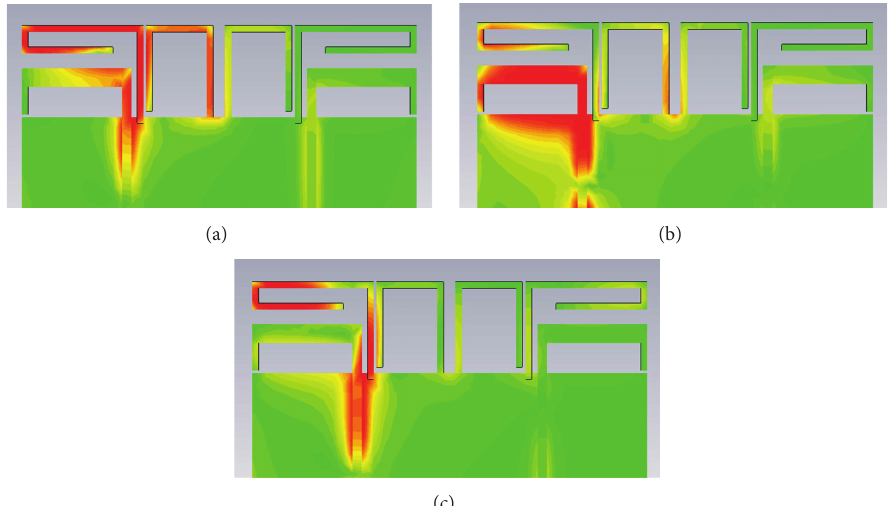
Figure 4: Surface current distribution of the proposed antenna at (a) 1.6 GHz; (b) 2.3 GHz; (c) 3.4 GHz.